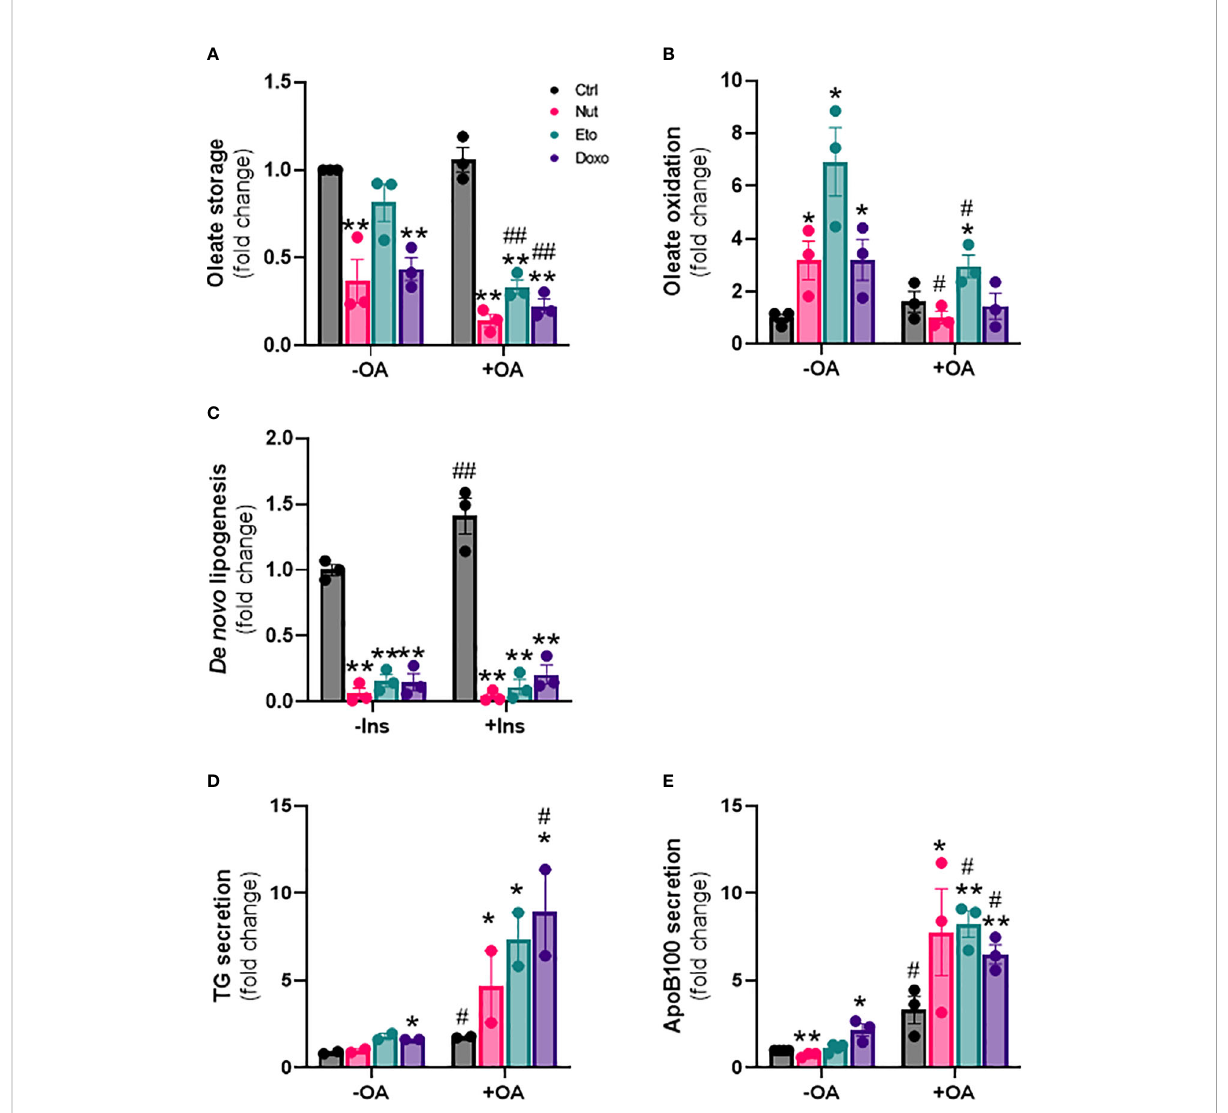
FIGURE 4 Cellular senescence decreases de novo lipogenesis and increases b -oxidation and VLDL production in human hepatocytes. IHH cells were treated with nutlin (Nut; 3 µM), etoposide (Eto; 20 µM) and doxorubicin (Doxo; 0,2 µM) for 5 days, with or without the addition of oleic acid (OA) for another 24h. (A) Oleate storage in IHH cells. Results were normalized to total protein levels. (B) b -oxidation in IHH cells. Results were normalized to total protein levels. (C) De novo lipogenesis in IHH cells with or without stimulation with insulin (100 nM) for 4h. (D) triglyceride and (E) apoB100 levels in IHH cell culture media. Results are expressed as Mean ± SEM. *P < 0.05, **P < 0.01 indicates a signi fi cant difference compared to control cells. # P < 0.05, ## P < 0.01 indicates a signi fi cant difference compared to similar treatment condition without